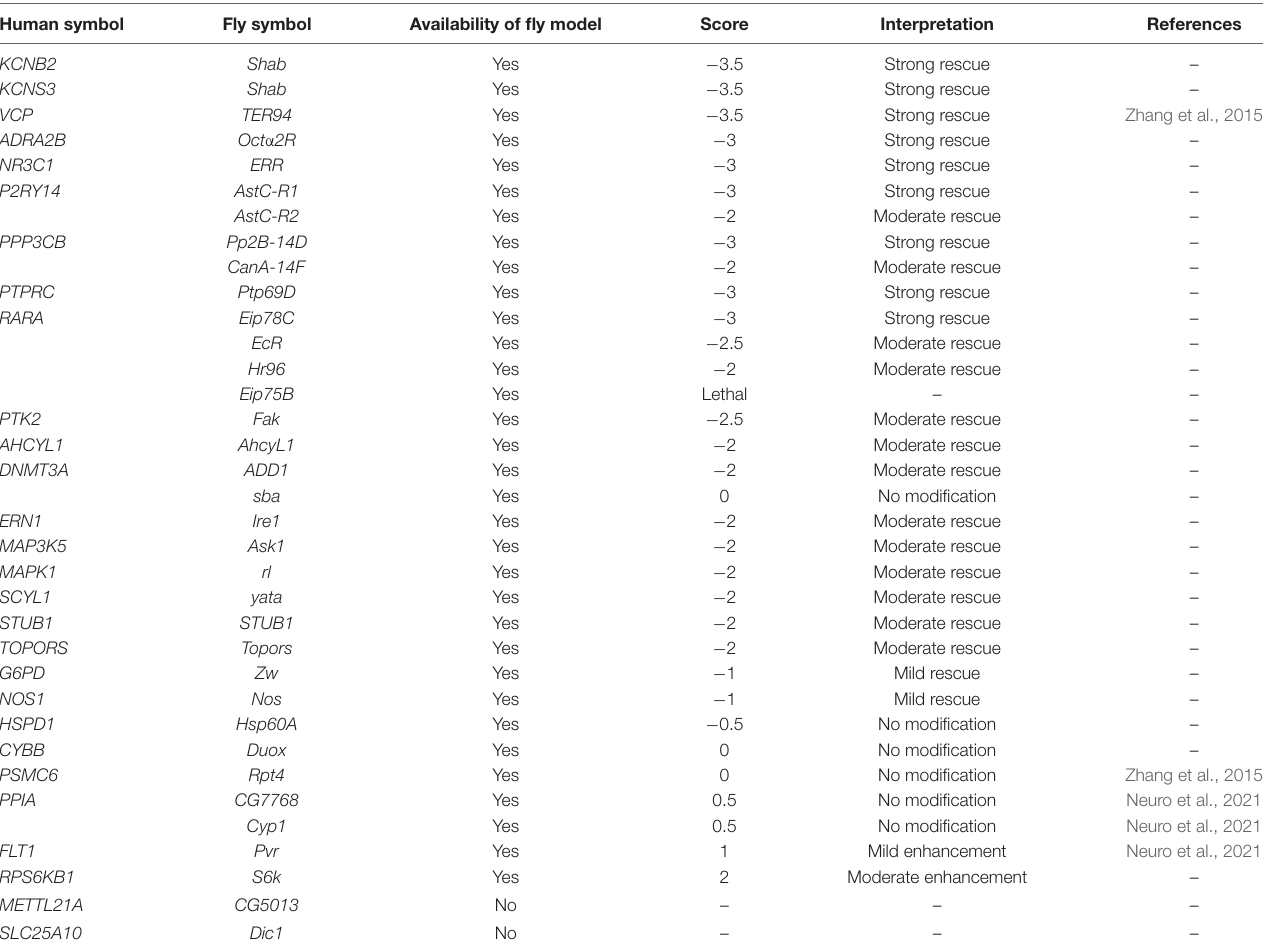
TABLE 3 | Screen results using a c9ALS Drosophila